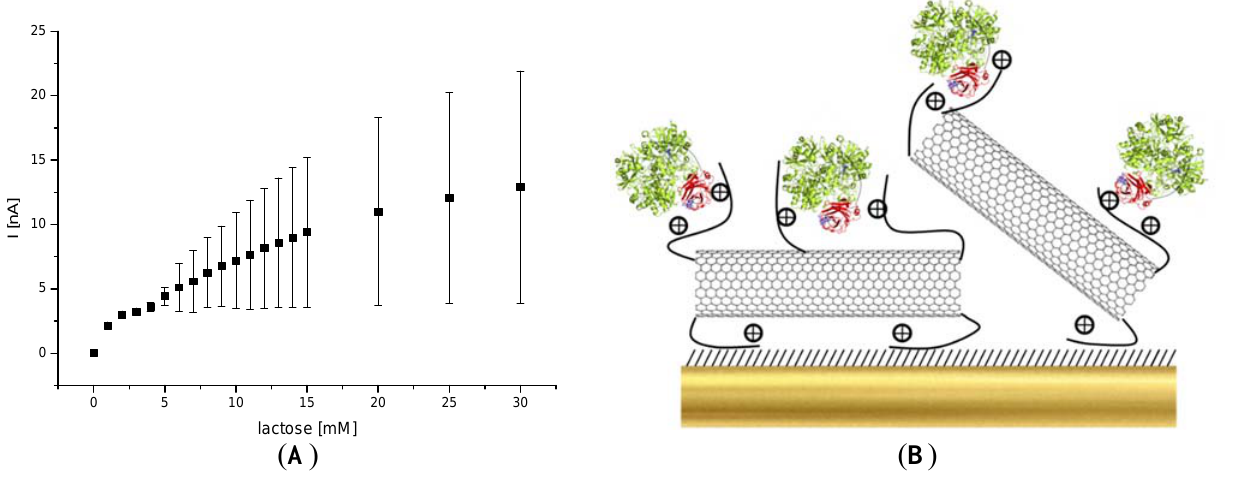
Figure 5. ( A ) Concentration dependence of the amperometric response of an Au-MPA-[MWCNT-P(AMB-A)-PDA]/CDH electrode for lactose (determined from I ssc of measurements at in 100 mM acetate buffer pH 3.5 at +100 mV; vs . Ag/AgCl, 1 M KCl). ( B ) Scheme of the CDH assembly on [MWCNT-P(AMB-A)-PDA] modified gold electrode. Heme domain is colored in red while the FAD domain is green.